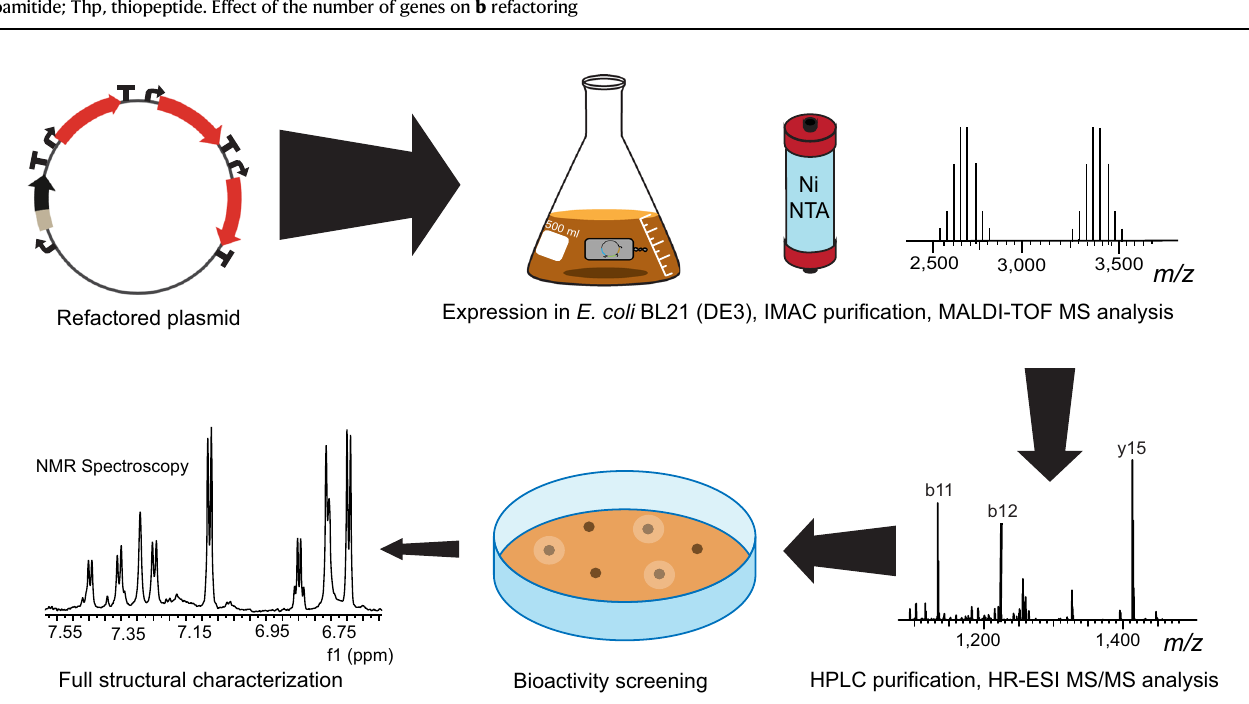
Fig.4|SchematicFAST-RiPPswork fl owforrapiddiscoveryofRiPPs. Refactored plasmidswereusedtotransform E.coli BL21(DE3)forexpression.Peptideproducts wereisolatedbyIMACpuri fi cationormethanolextractionandanalyzedbyMALDI- TOF-MS. Peptides with modi fi cations were puri fi ed by reversed-phase HPLC and analyzed by HR-ESI-MS/MS to locate the site(s) of modi fi cation. Leader peptides